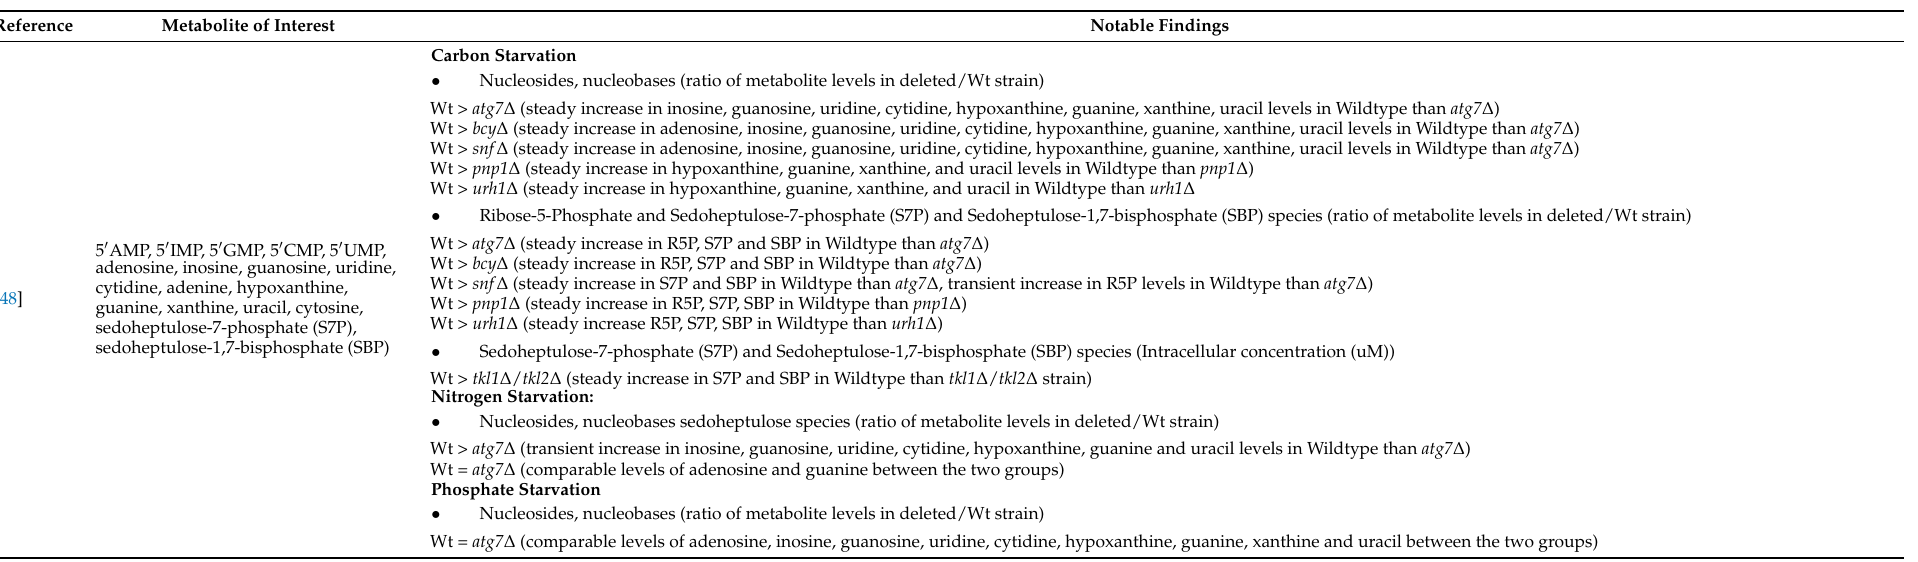
Table 2. The summary of data extracted from eligible articles. Abbreviations: Wt (Wildtype), AMP (Adenosine Monophosphate), IMP (Inosine monophosphate), GMP (Guanosine monophosphate), CMP (Cytidine monophosphate), UMP (uridine monophosphate) (>) indicates high levels of metabolites seen in one group in contrast to the other. (<) indicates, low levels of metabolites observed in one group in comparison to the other. (=) indicates comparable levels of metabolites demonstrated in both